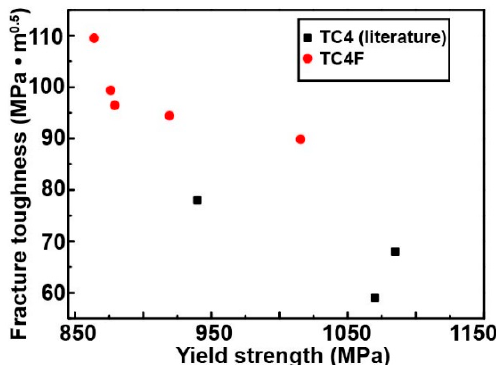
Figure 17. Comparison of mechanical properties BASCA heat-treated TC4F and TC4 [24].